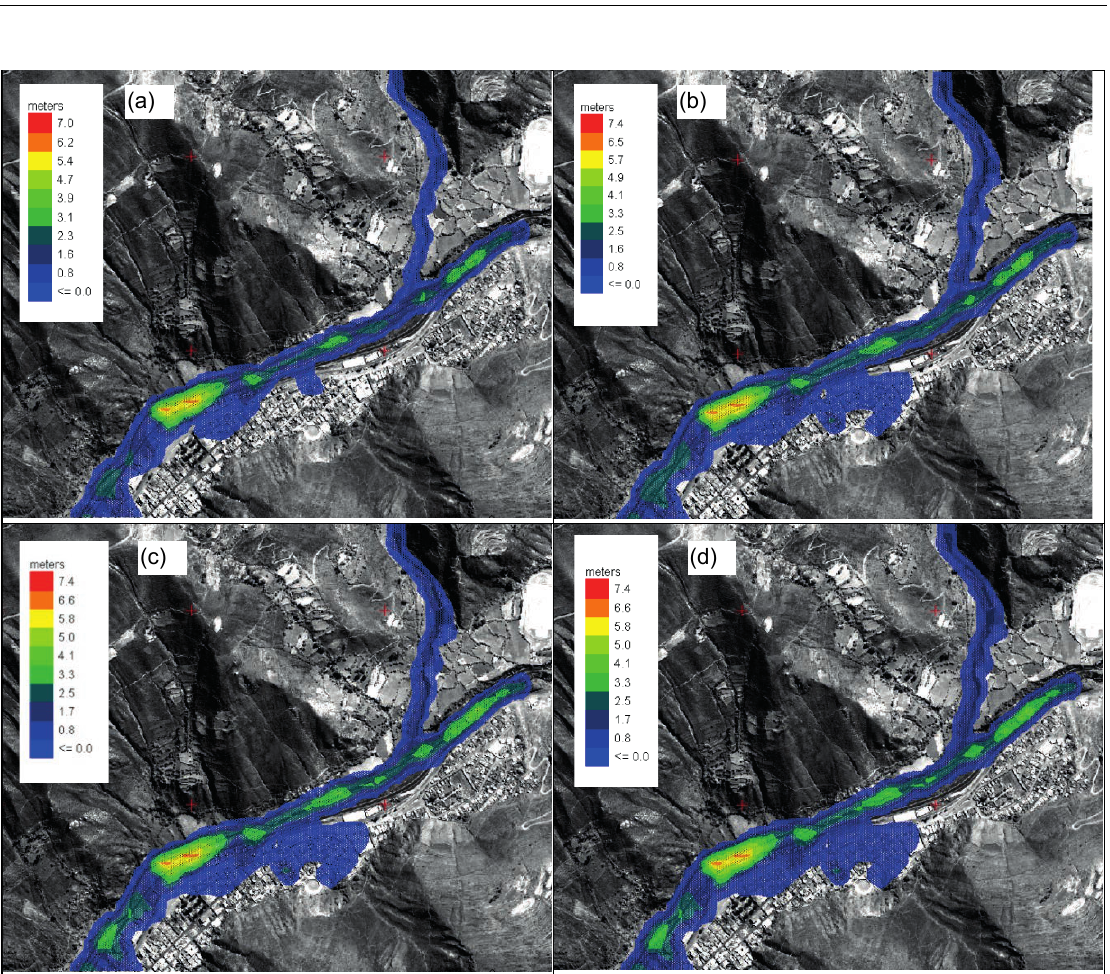
Fig. 2 Maximum inundated areas and maximum depth of water in Matucana village. (a) Scenario without climate change. (b) Maximum scenario 2010–2039. (c) Maximum scenario 2040–2069. (d) Maximum scenario 2070–2099. Emission scenario A1FI. Region